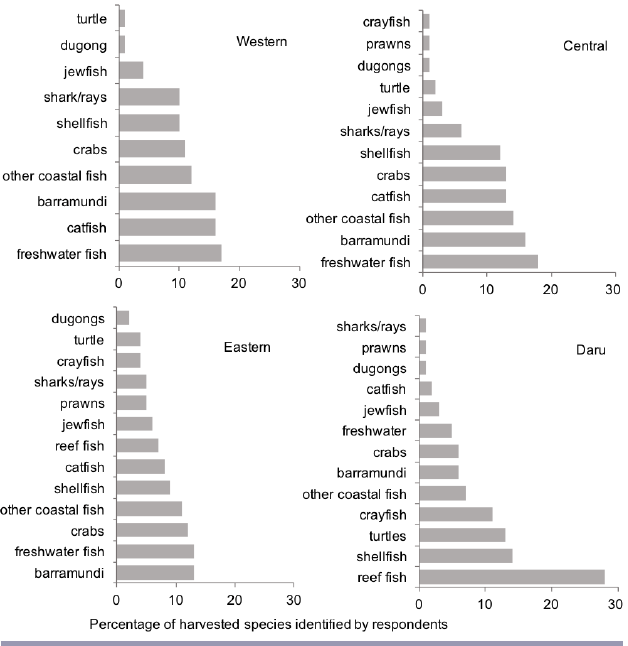
Fig. 4 . Harvested species as reported by respondents during the household surveys, presented as percentages of respondents who mentioned each